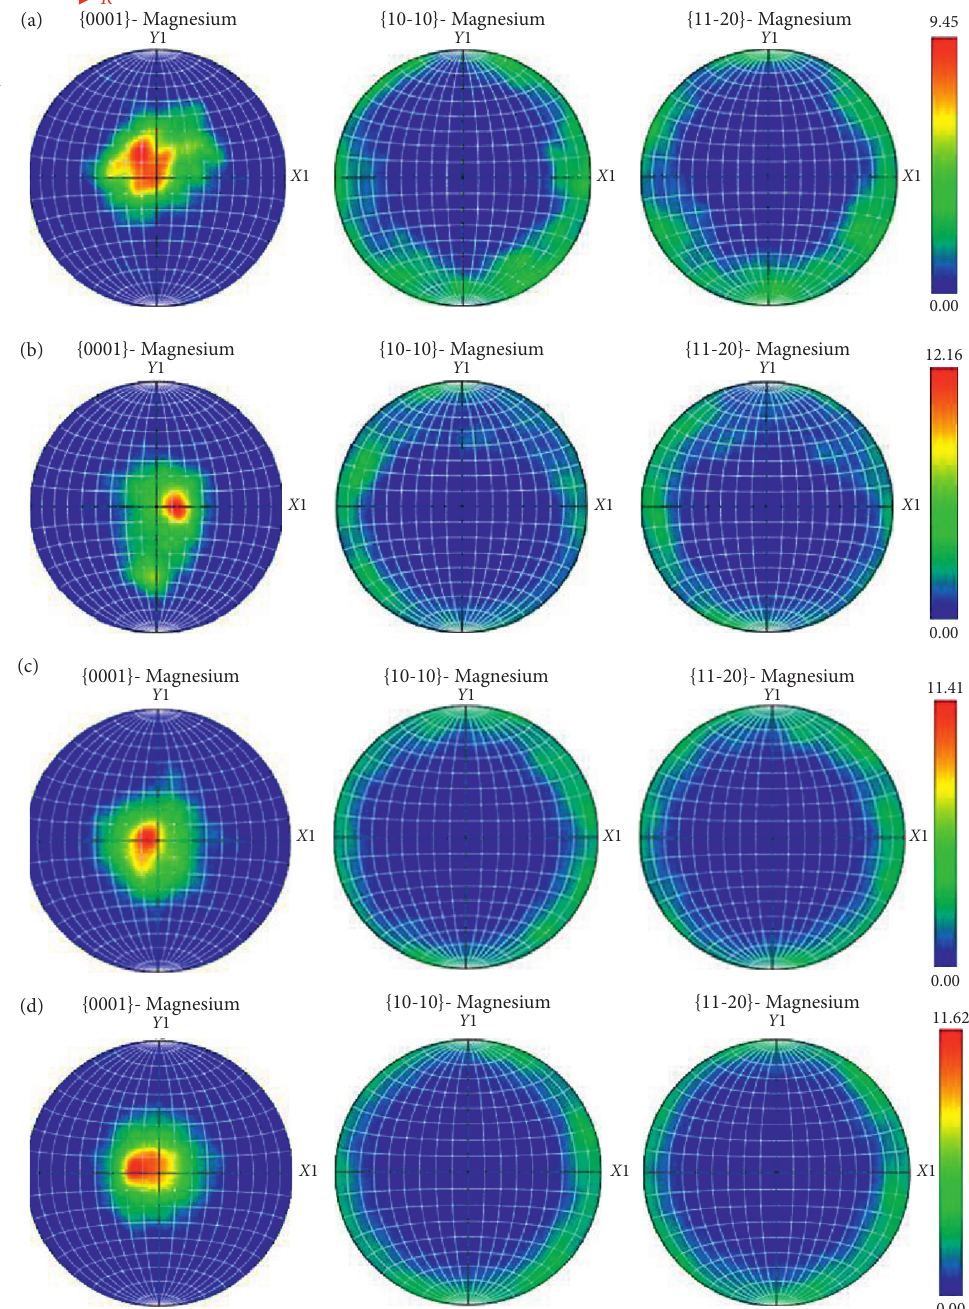
Figure 2: Basal plane (0002), prismatic plane (10-10) and (11-20) pole figures of Mg-6Sn-3Al-Zn alloys rolled at different temperatures: (a) 300 ° C, (b) 350 ° C, (c) 400 ° C, and (d) 450 °